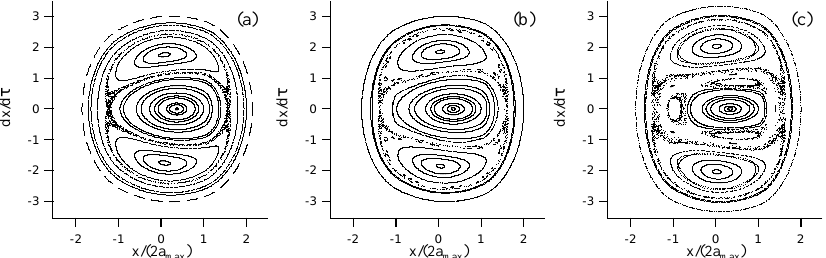
FIG. 9. The Poincaré surface of section plots for test particles in high density cases. The test particle position scaled by the maximum beam boundary width 2 a max (cid:1) 2 a (cid:4) 0 (cid:5) is taken as the abscissa. Beams with three different densities, i.e., (a) h x (cid:1) 0.5 , (b) h x (cid:1) 0.4 , and (c) h x (cid:1) 0.3 , are considered. Other parameters are fixed to M (cid:1) 0.10 , L (cid:1) 4 , and j (cid:1) 0.15